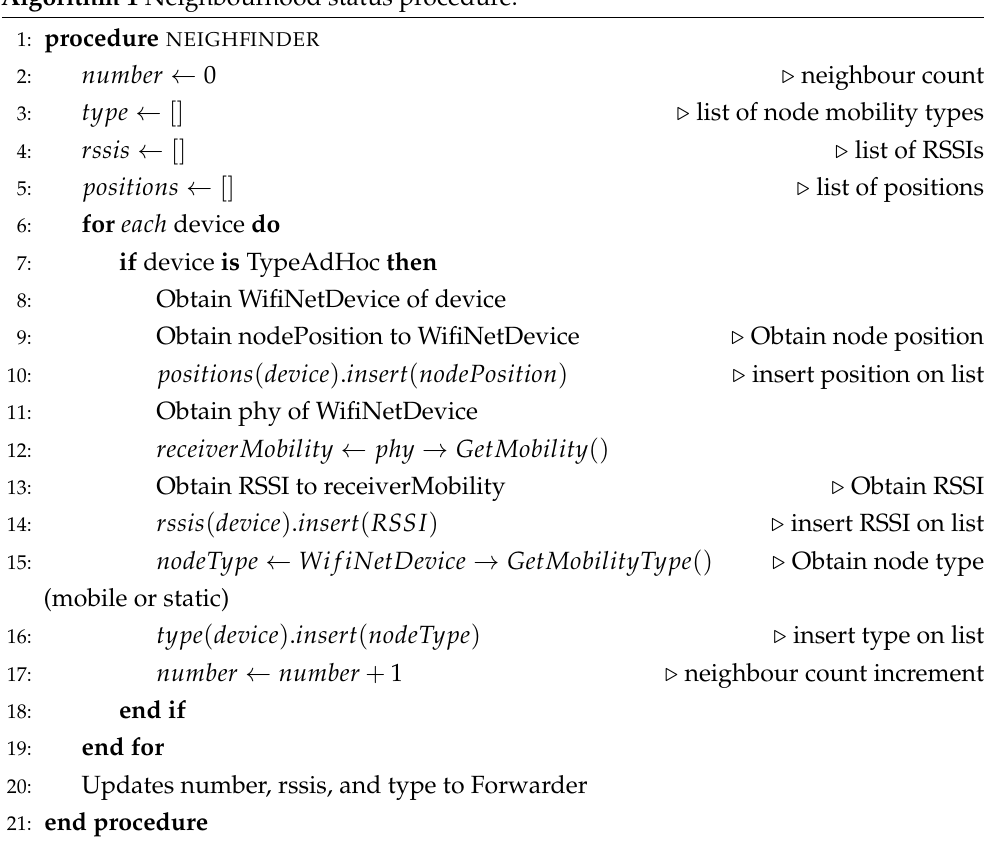
Figure 5. Node heading calculation: two distinct situations. Algorithm 1 Neighbourhood status